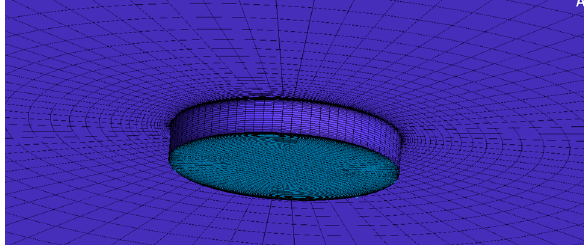
Figure 7. Detail of the geometry adopted to simulate the flow coming out of an orifice.